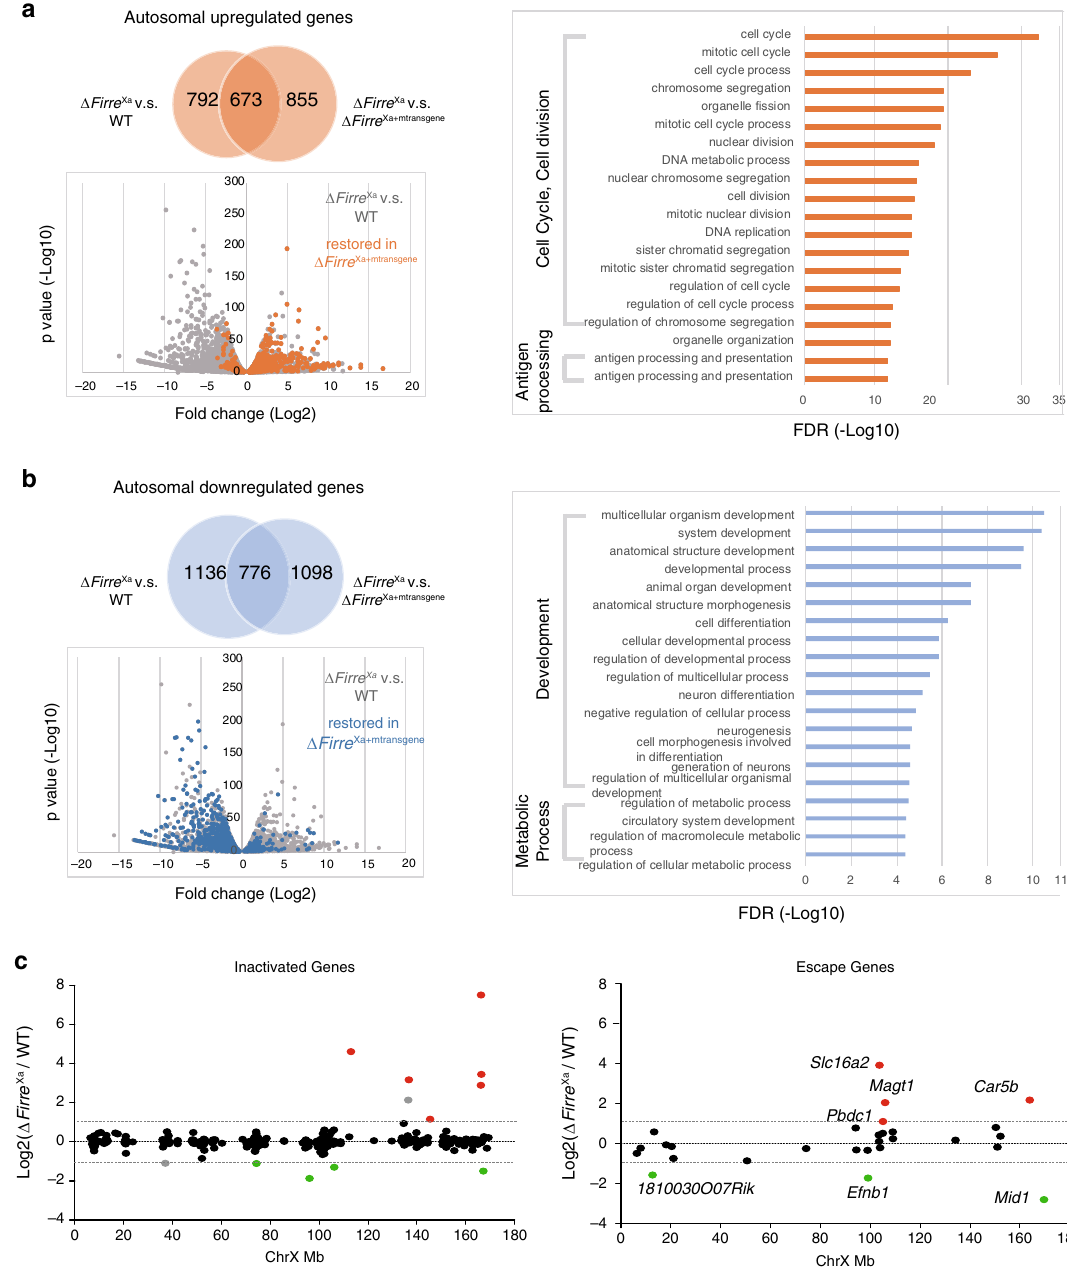
Fig. 6 Loss of Firre RNA affects gene expression. a Upregulated genes in Δ Firre Xa and Gene Ontology (GO) term enrichment. The Venn diagram shows the number of upregulated genes in Δ Firre Xa versus WT, and in Δ Firre Xa versus Δ Firre Xa + mtransgene , with the overlapping gene set representing upregulated genes in Δ Firre Xa that are rescued by transgene expression. The scatter plot shows dysregulated genes in Δ Firre Xa versus WT (grey), with genes rescued by reduced expression in Δ Firre Xa + mtransgene versus Δ Firre Xa (more than 2-fold; p value < 0.05 by the Wald test) highlighted in orange. The top 20 GO terms of overlapping upregulated genes in Δ Firre Xa versus WT, which are rescued in Δ Firre Xa + mtransgene are listed. The X -axis indicates the FDR ( − log10). b Downregulated genes in Δ Firre Xa and Gene Ontology (GO) term enrichment. The Venn diagram shows the number of downregulated genes in Δ Firre Xa versus WT, and in Δ Firre Xa versus Δ Firre Xa + mtransgene , the overlapping gene set representing downregulated genes in Δ Firre Xa that are rescued by transgene expression. The scatter plot shows dysregulated genes in Δ Firre Xa versus WT (gray), with genes rescued by increased expression in Δ Firre Xa + mtransgene versus Δ Firre Xa (more than 2-fold; p value <0.05 by the Wald test) highlighted in blue. The top 20 GO terms of overlapping downregulated genes in Δ Firre Xa versus WT, which are rescued in Δ Firre Xa + mtransgene are listed. The X -axis indicates the FDR ( − log10). c Xi-expression fold changes for genes that are subject to or escape XCI between Δ Firre Xa and WT. Upregulated genes are in red and downregulated genes in green. To note, one upregulated gene and one gene subject to XCI are in gray, as they showed more than 2-fold change in expression but with a p value >0.05 by the Wald test in Δ Firre Xa versus WT. Genes are ordered from centromere to telomere along the